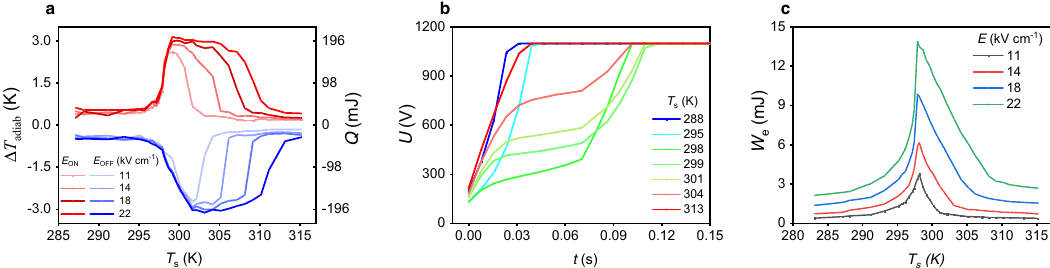
Fig. 3 PST-heat exchanged Q and electrical work W e . a Direct Δ T adiab measurements and electrocaloric heat Q of PST as a function of starting temperatures T s under application (red curves) and removal (blue curves) of 11, 14, 18, and 22 kV cm − 1 . The protocol carried out to measure Δ T adiab is detailed in Supplementary Note 9. Q is calculated from directly measured Δ T adiab and constant background value of C p . b Example of charge in PST capacitor at a maximum voltage of 1100 V (22 kV cm − 1 ) as a function of time t at selected T s . c Electrical work W e needed to charge a PST capacitor as a function of T s at different electric fi elds E . W e is obtained from the data of voltage (Fig. 3b) across PST at constant Fig. 12 about adiabatic conditions). Reproducible Δ T adiab mea-